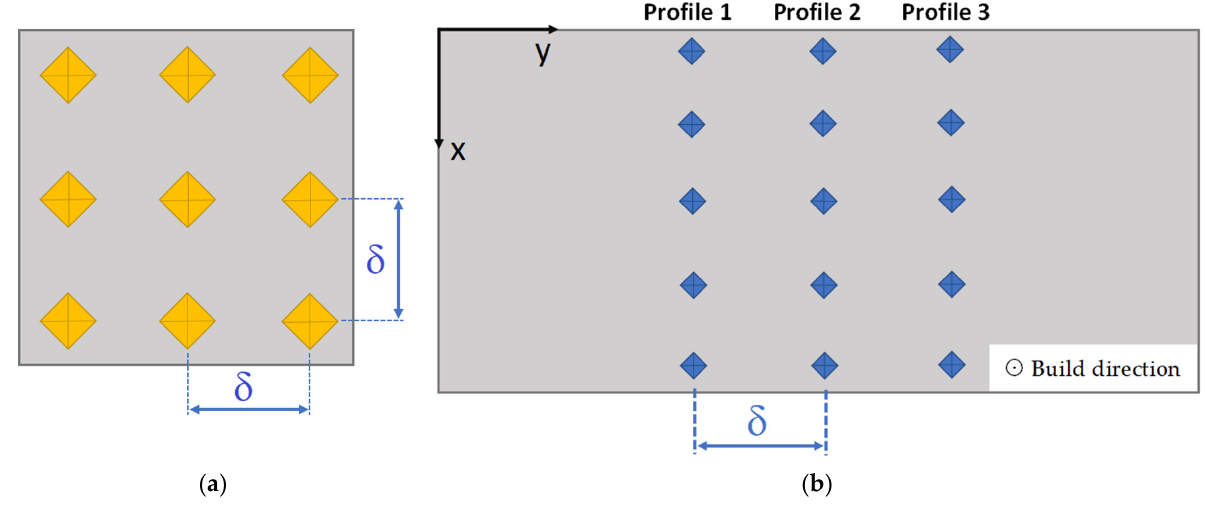
Figure 3. ( a ) Matrix of 3 × 3 indentations where d is 1 mm of space between two adjacent indentations; ( b ) Vickers microhardness profiles performed on cross-section of the heat-treated 90 ◦ Z -samples after and before the sandblasting process. Each profile is separated by δ .